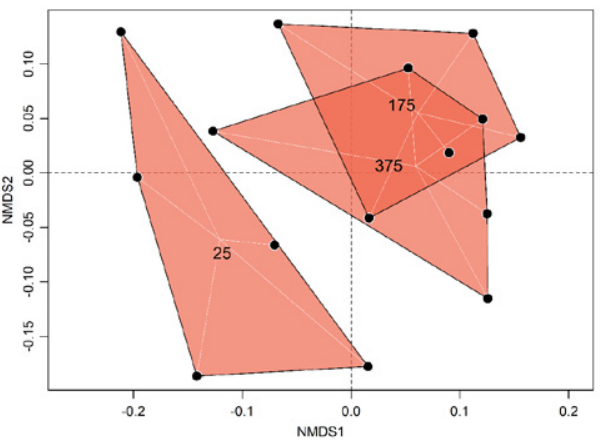
Fig 5 . Non-metric multidimensional scaling: bee composition visiting canola crops in Southern Brazil. Note: numbers inside polygons indicate the set of distances from wild vegetation; points means sample units; White lines are spider bodies calculated as centroids (averages) of polygons.